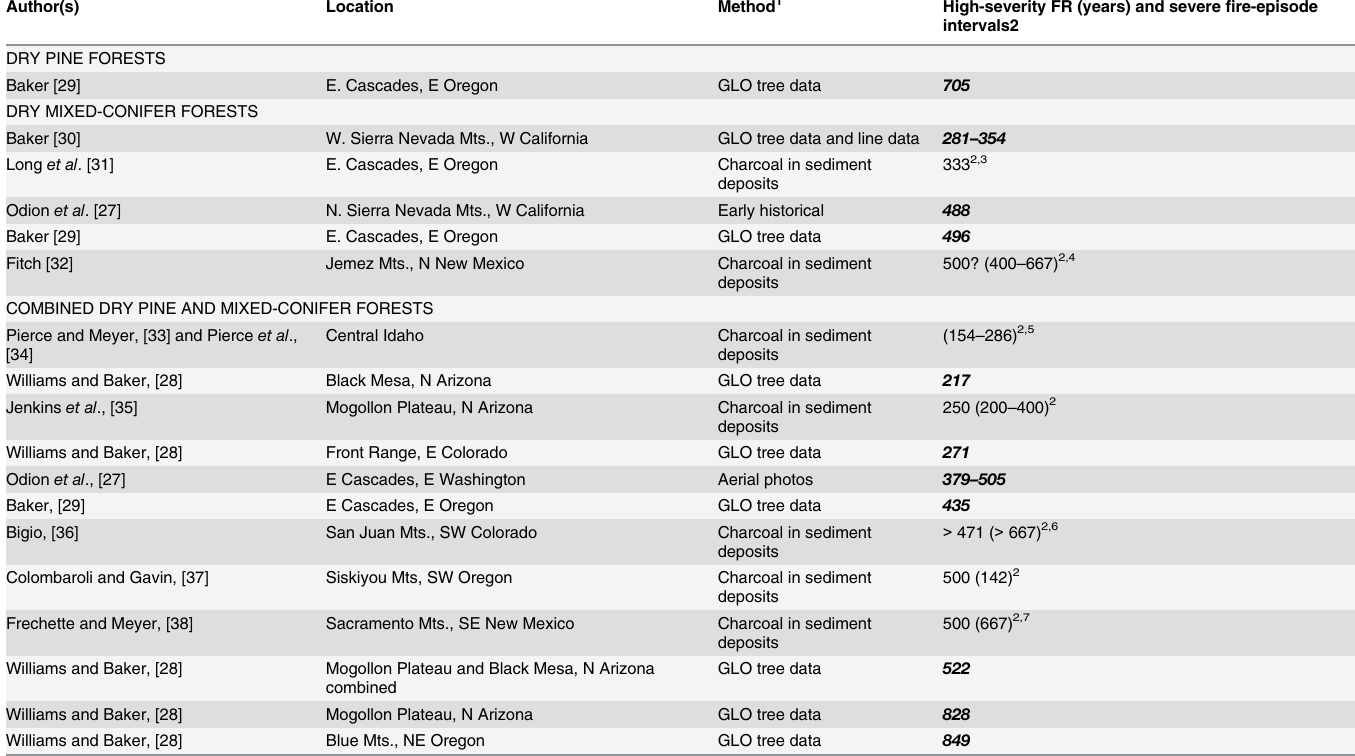
Table 1. Reconstructions of fire rotation (FR) for high-severity fire in historical dry forests of the western USA, with corroborating evidence from sedimentary charcoal studies.